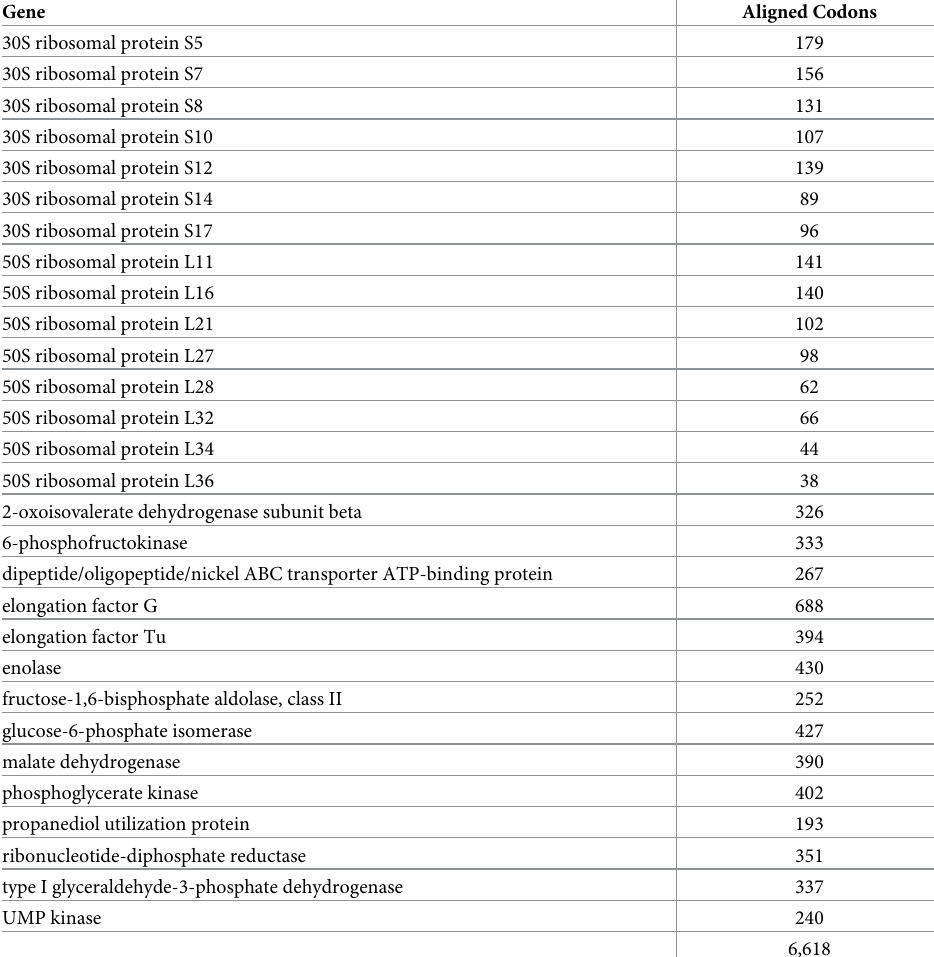
Table 1. Conserved genes present as single copies in AY-WB, CX, NJAY, OY-M, PAa and SLY. Gene Aligned